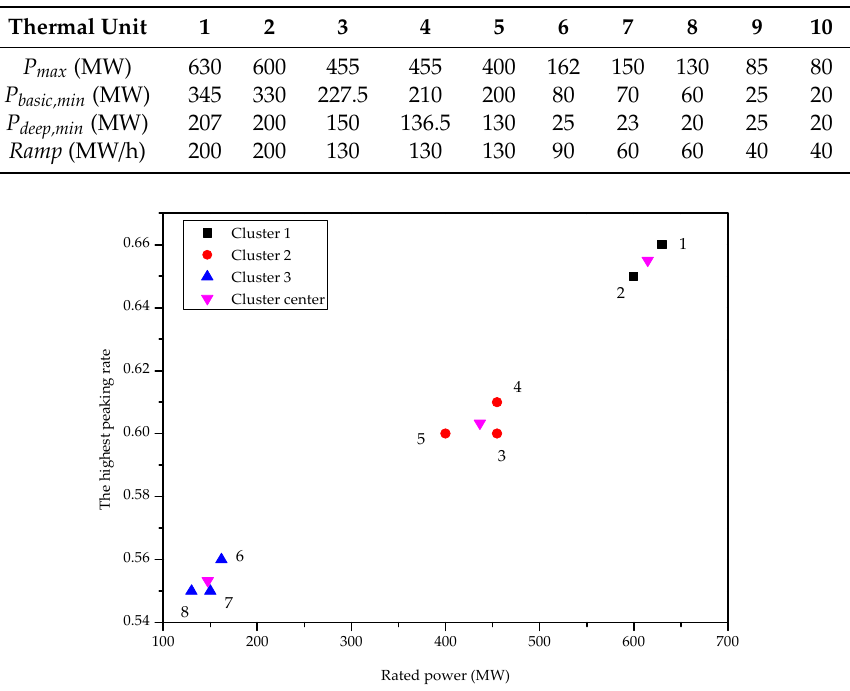
Table 1. The Thermal Unit Parameters.